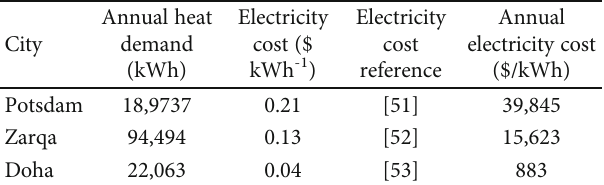
Table 8: Hotel ’ s electricity demand cost for the three